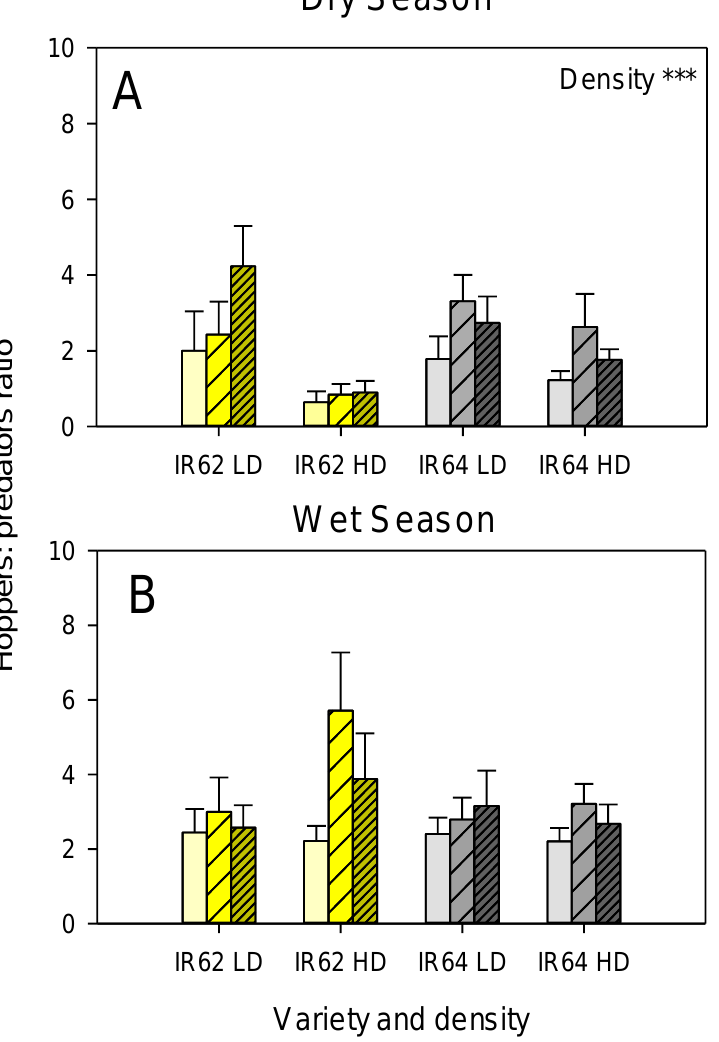
Figure 6. Hopper: predator ratios in rice plots with resistant (IR62: yellow bars) and susceptible (IR64: grey bars) rice transplanted at low (LD) and high (HD) densities under varying nitrogen fertilizer treatments. Nitrogen was applied at 0 Kg ha − 1 (open bars), 60 Kg ha − 1 (hatched bars), and 150 Kg ha − 1 (densely-hatched bars). The factors that significantly affected ratios are presented with significance level as *** = p ≤ 0.005. Sampling was conducted during the dry ( A ) and wet ( B ) seasons using blow-vac samplers. Standard errors are indicated ( N = 6).